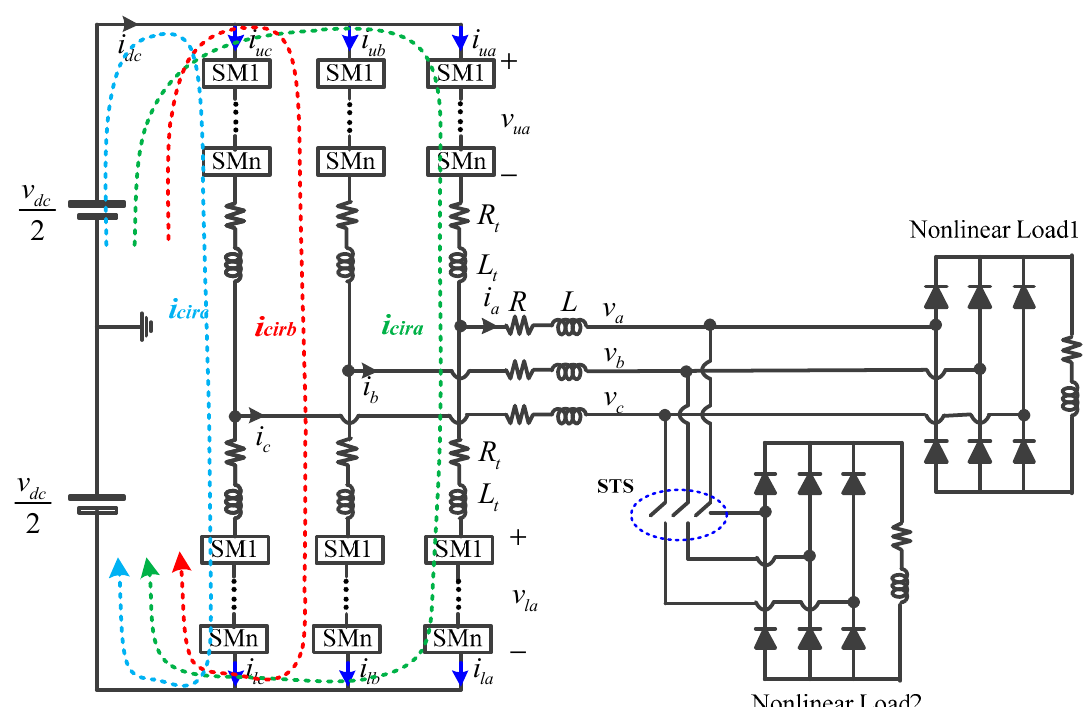
Figure 1. The configuration of the modular multilevel converter (MMC) under study.